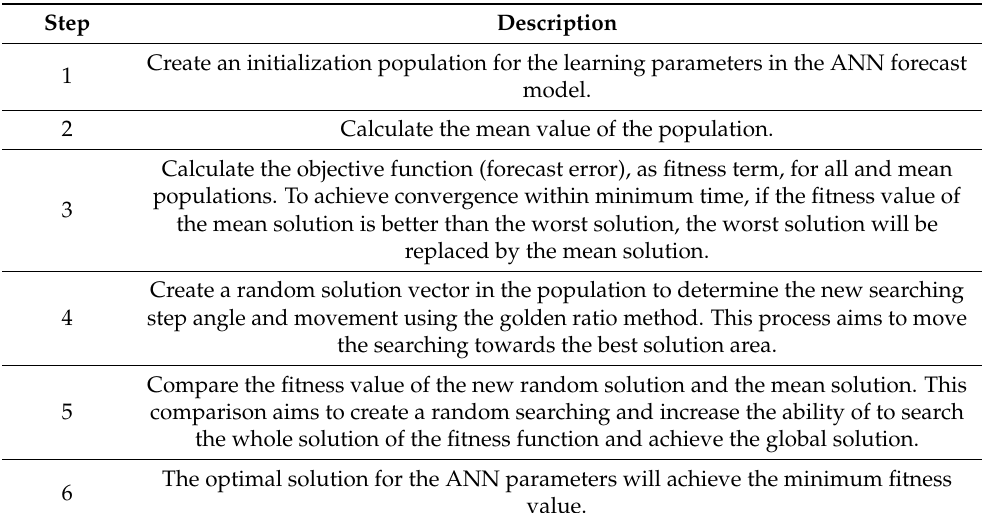
Table 3. The GROM learning procedure in the ANN forecast